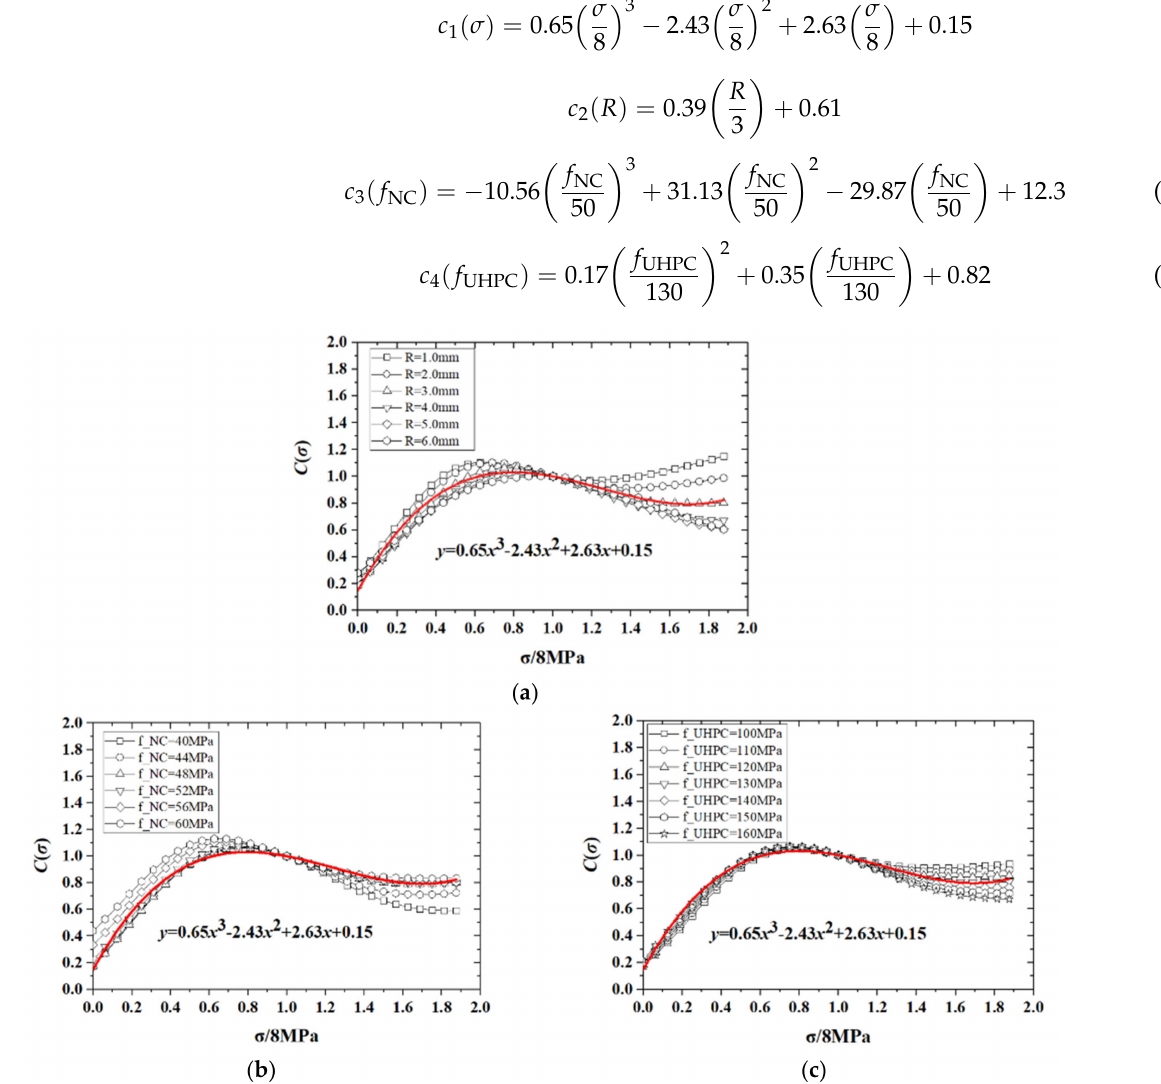
Figure 7. Correction factor c 1 ( σ ) with respect to different factors. ( a ) with R ; ( b ) with f NC ; ( c ) with f UHPC